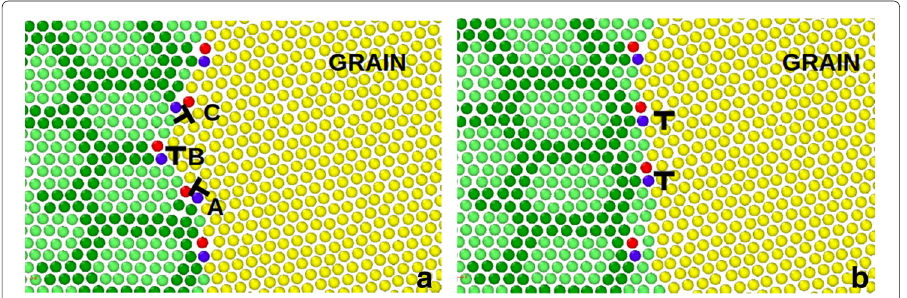
Fig. 5 Dislocation annihilation. Dislocations are represented by a 5-7 pair in blue and red. a The grain is shown in yellow, the matrix in light green. We colored the planes along which the dislocations have glided in dark green in order to keep track of the paths on which they glided. b Dislocations A, B, C with Burgers